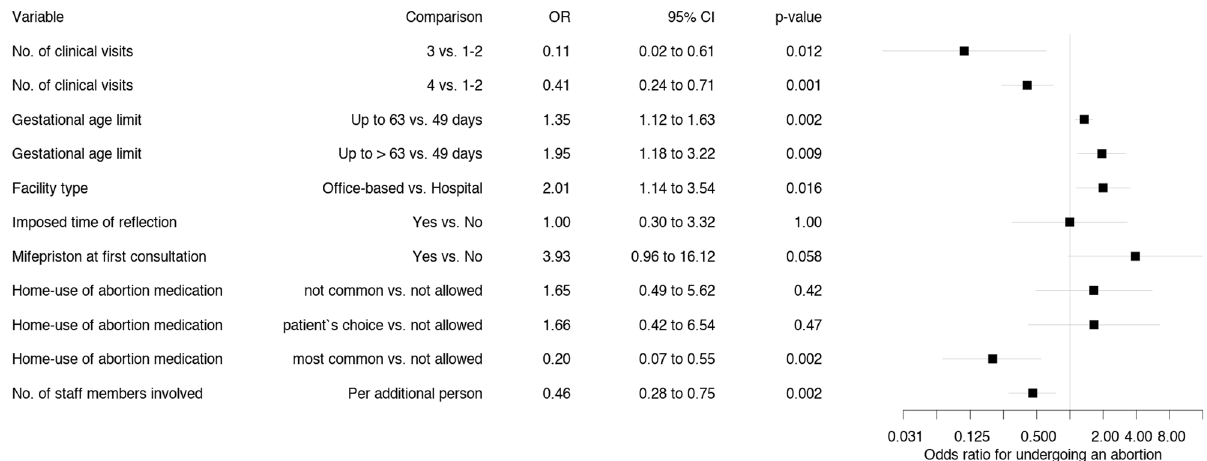
Figure 3. Association between protocol characteristics and the proportion of patients who followed through with the abortion at the same facility. Odds ratios were estimated by a multivariable variable GEE model (referred to as full model in the